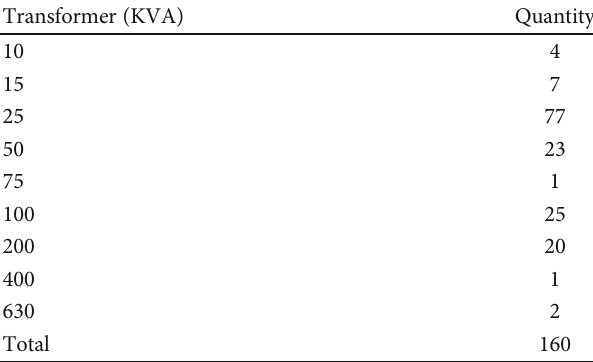
Table 2: CITY-3 feeder distribution transformers [17].